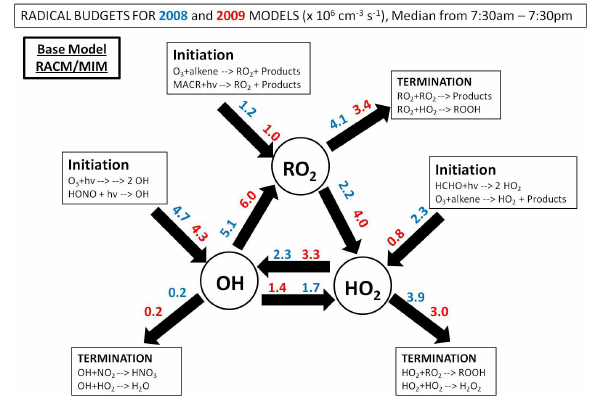
Figure 10: PROPHET 2008 ( blue ) and CABINEX 2009 ( red ) radical budget rates for the time period of 7:30 am -7:30 pm. Primary reactions contributing to the initiation, termination, and propagation routes are shown in the boxes.